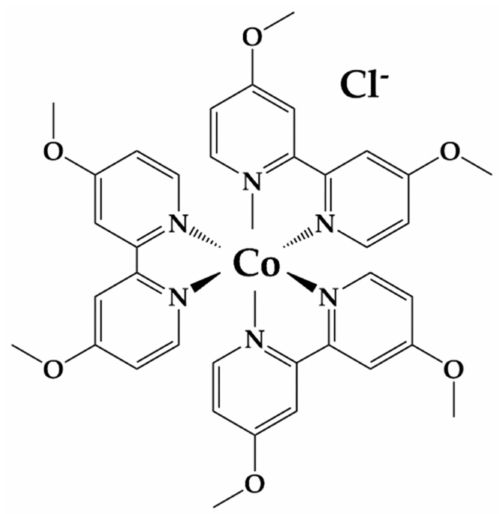
Figure 5. Chemical structure of aqueous-soluble Co II/III redox mediator.